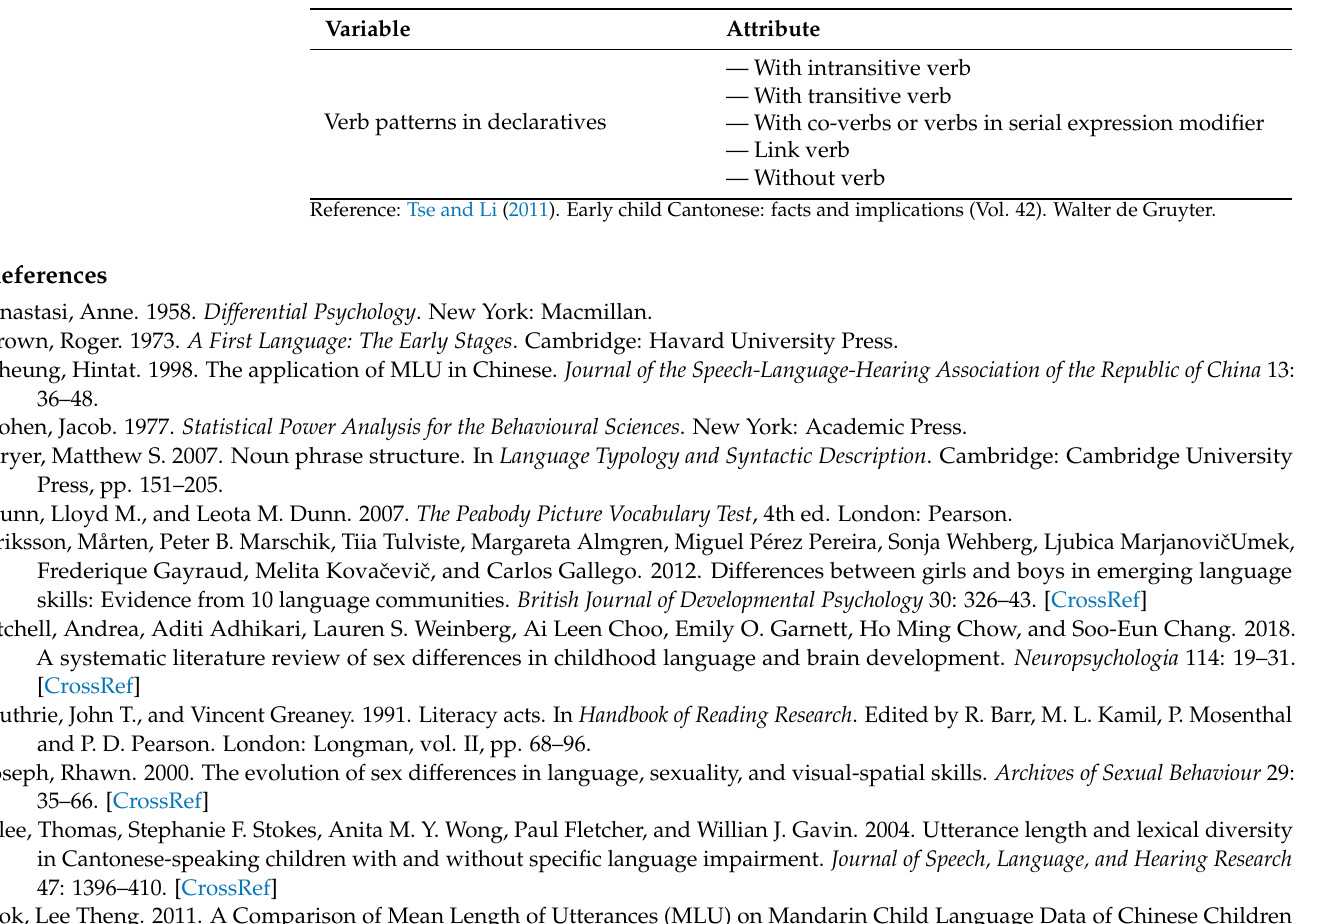
Table A1. Cont. Variable Attribute